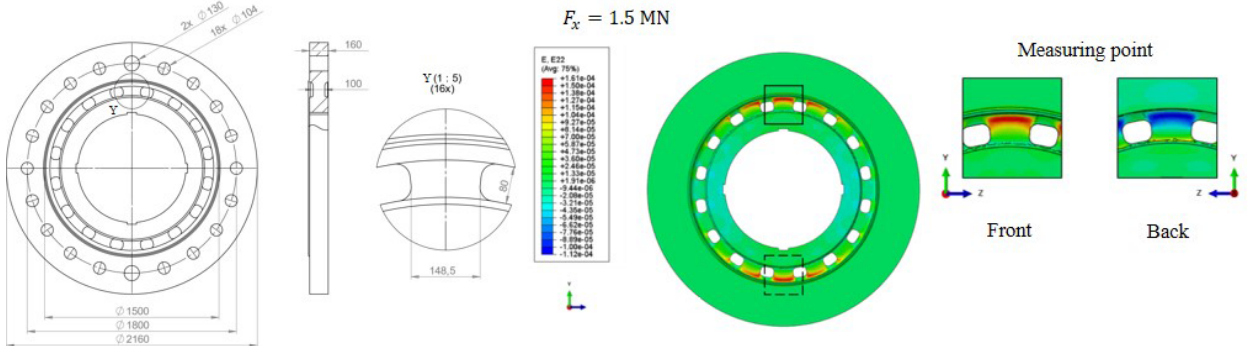
Figure 12. Axial force element dimensions and the distribution of the nominal strain in the y direction at the measuring point of axial force under nominal axial force of 1.5MN.